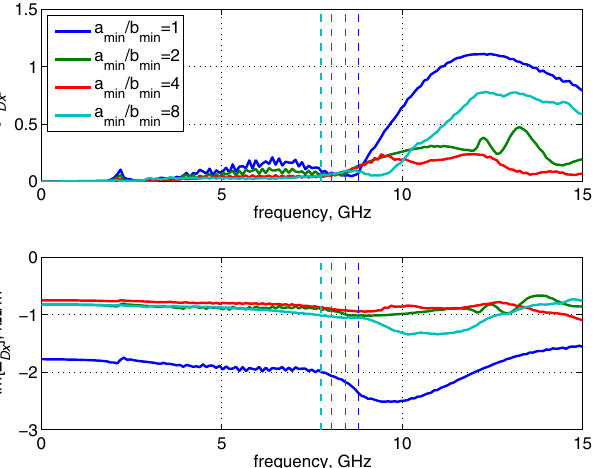
FIG. 7. (Color) Dipolar vertical impedance (solid line) and cutoff frequencies of the structure (dashed line).